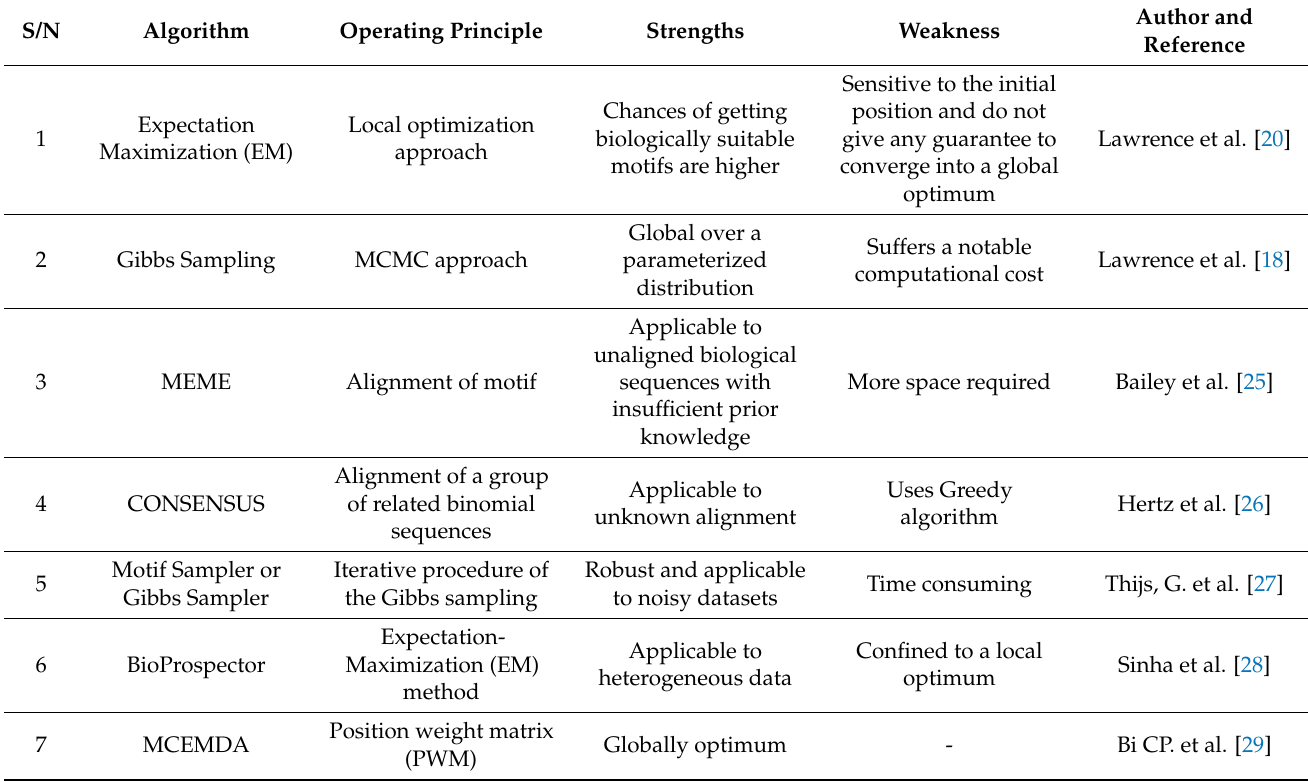
Table A1. List of Motif Discovery Algorithms based on Probabilistic